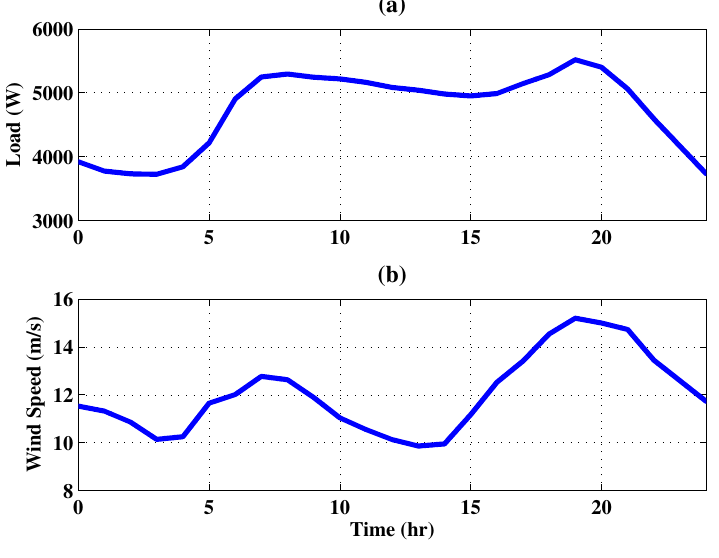
Figure 14. ( a ) Load and ( b ) wind speed profiles for the simulated 24-h period.